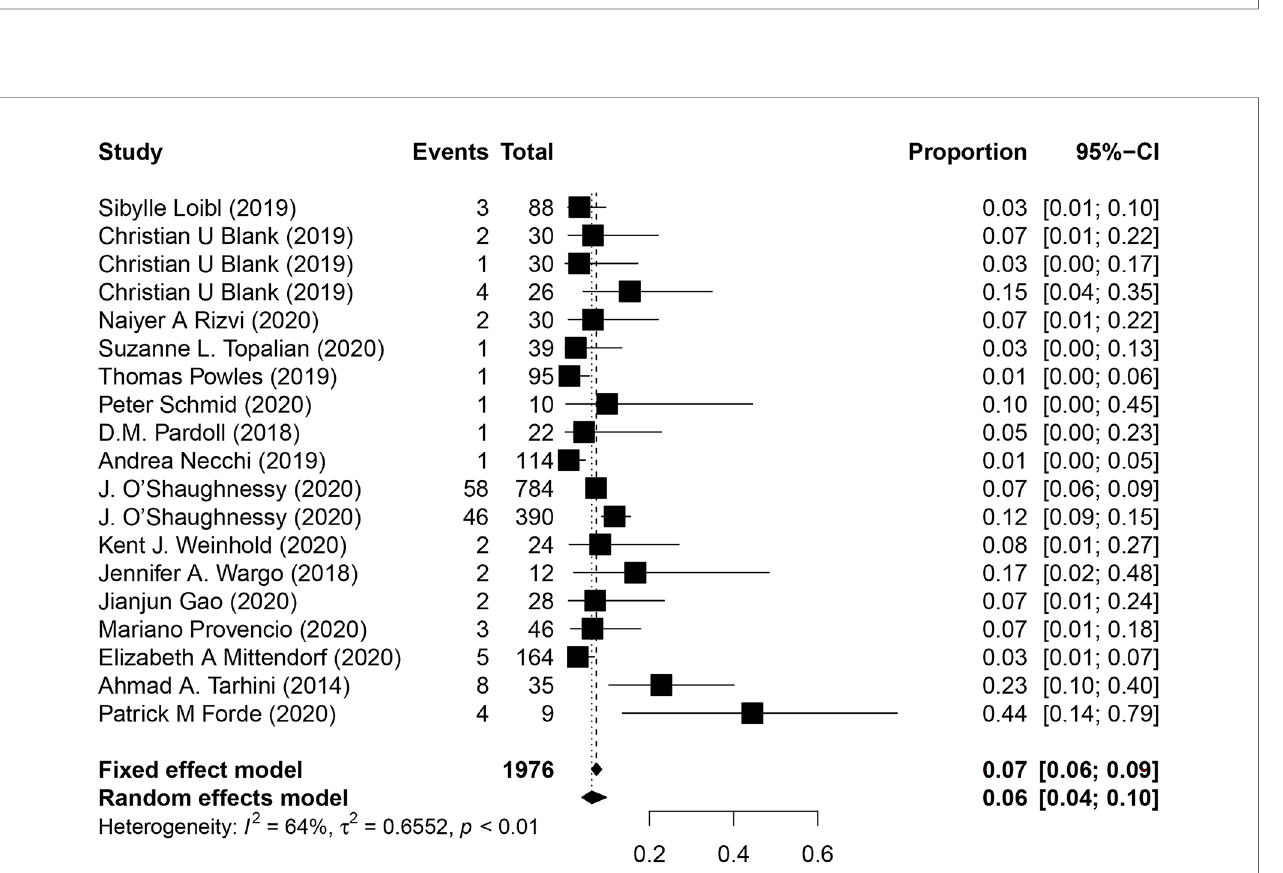
FIGURE 5 | Pooled analysis of progressive diseases in neoadjuvant immunotherapy. CI, con fi dence